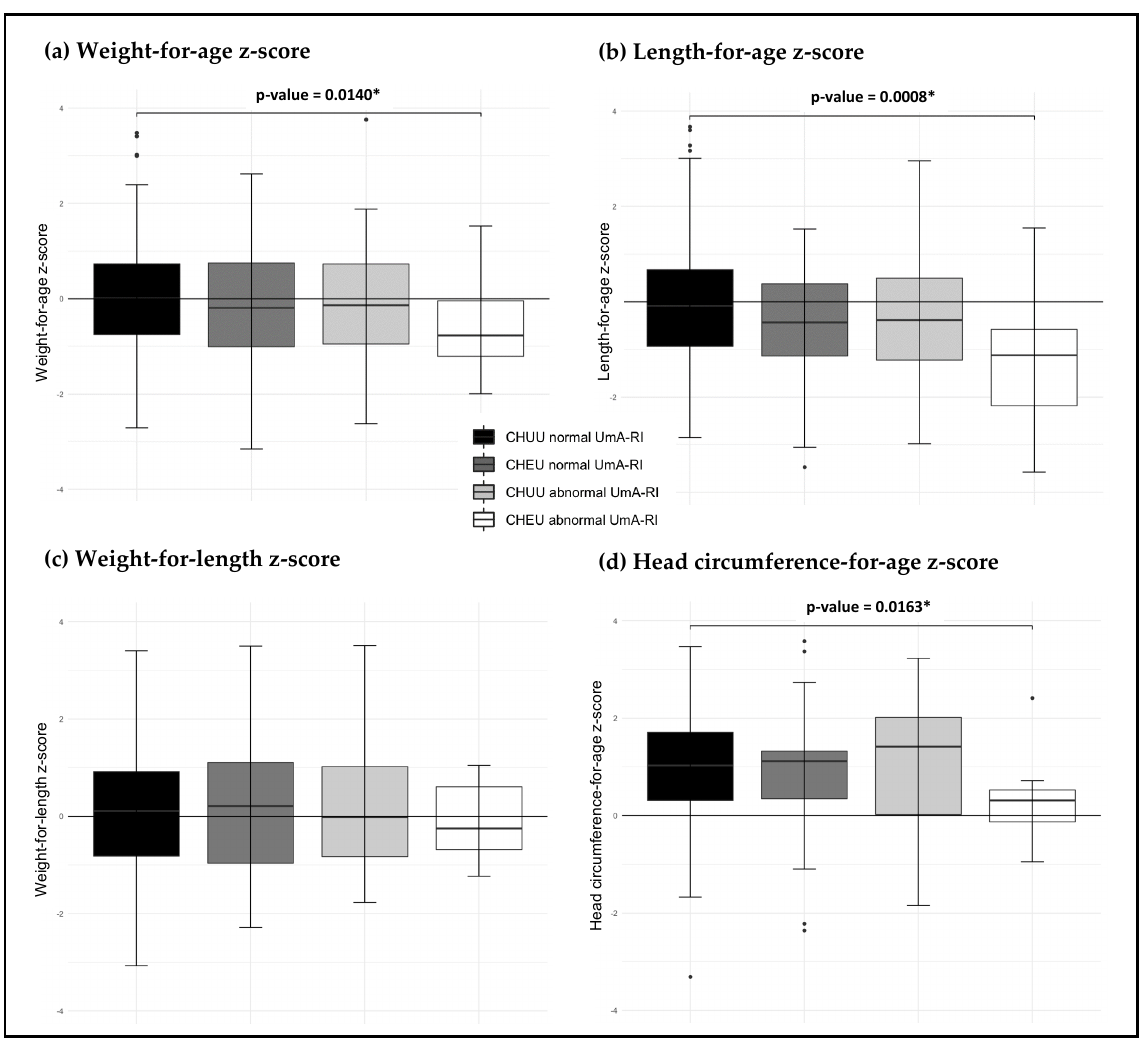
Figure 2. The box plots showing the significant differences for weight-for-age z-score, length-for-age z-score, weight-for-length z-score and HC-for-age z-score between the study groups. The